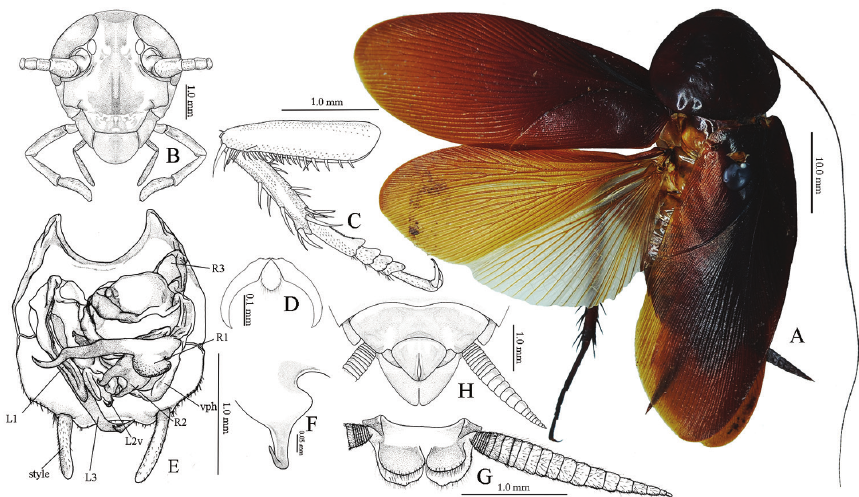
Figure 2. Periplaneta banksi Hanitsch, 1931: A Adult female B head C prothoracic leg D tarsal claws E male genitalia: (L1-3: left phallomere sclerites; L2v: L2 ventral sclerite; R1-3: right phallomere sclerite; vph: ventral phallomere) F L2v close-up G male supra-anal plate H female subgenital plate.